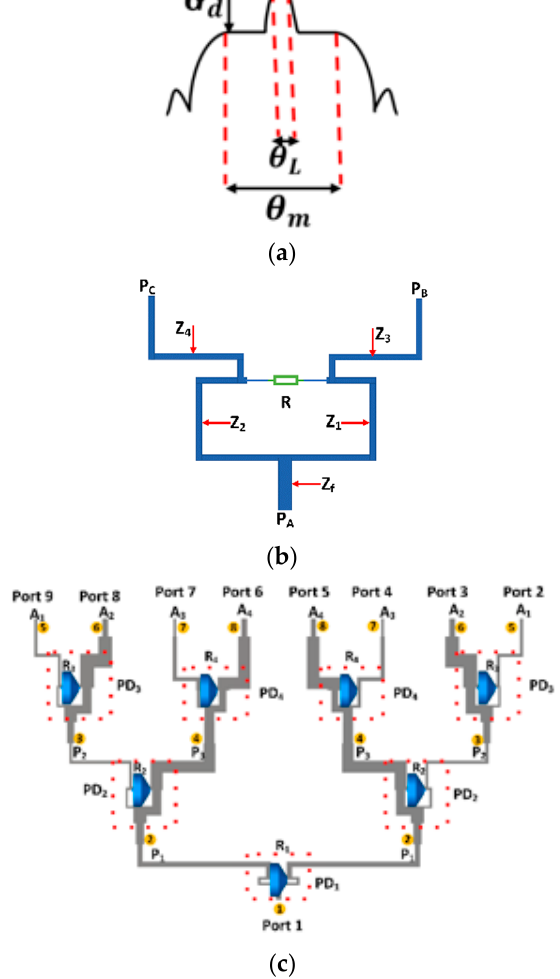
Figure 3. ( a ) Proposed flat-shoulder shape (FSS), ( b ) reference power divider, and ( c ) proposed feeding network.